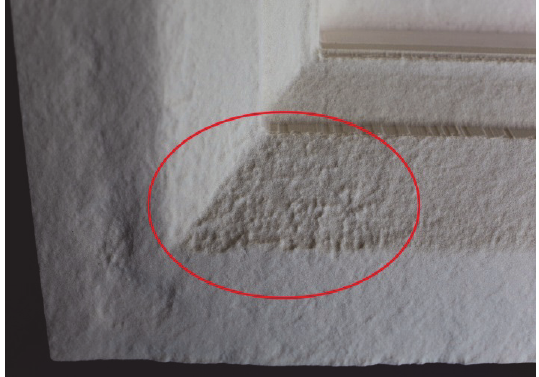
Figure 3. Pilaster capital (top) and 1:1 3D-printed capital maquette